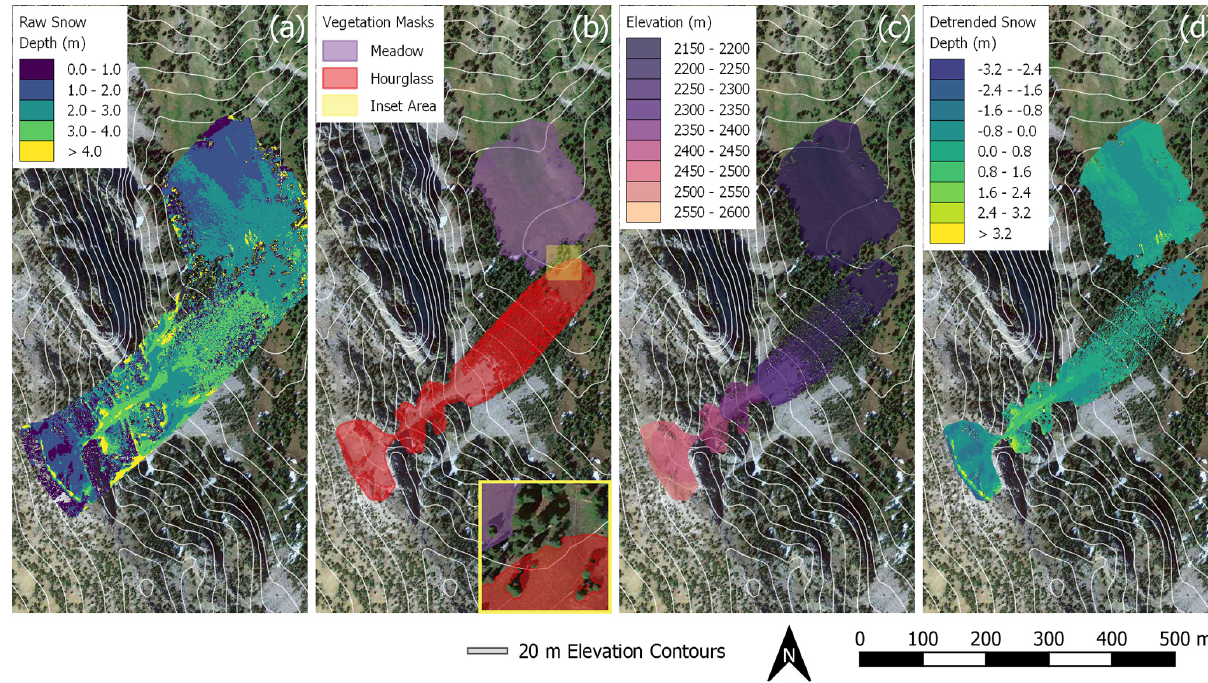
Figure 3. Vegetation masking and detrending processes for raw snow depth values from 21 February 2020 derived from DSM differencing. The scene-wide raw snow depth (a) map is shown prior to vegetation masking (b) and elevation detrending (c) , resulting in the detrended snow depth map (d) used for snow depth spatial-variability analysis. The inset map (yellow – lower right) of the vegetation mask map (b) illustrates the masks’ removal of trees and other vegetation. Elevations (c) are from the 8 July 2022 snow-free DSM. Note that detrended snow depths (d) result in negative values at upper elevations. Map satellite imagery: © Google, © 2022 USDA/FPAC/GEO, Maxar